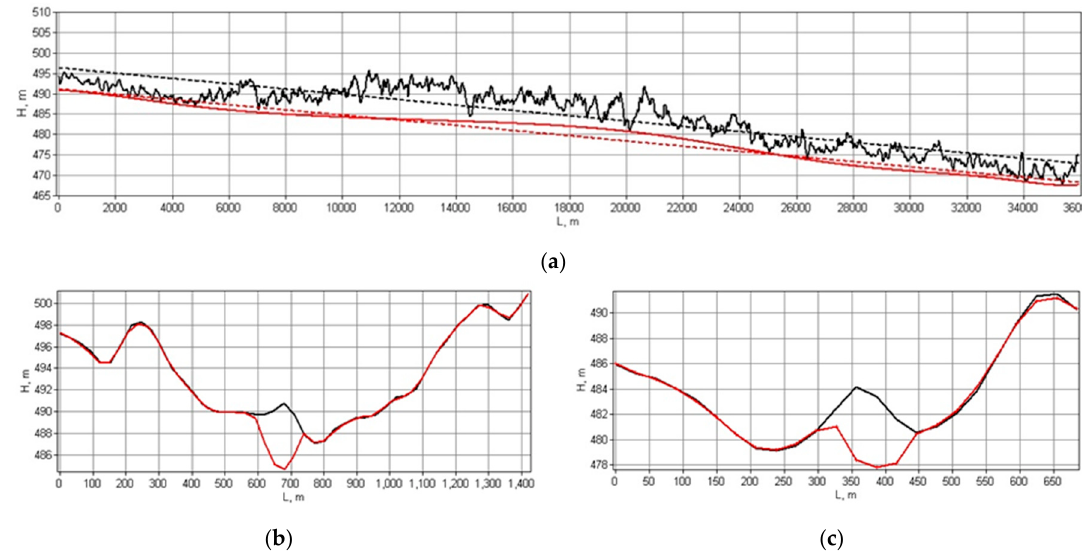
Figure 4. ( a ) Longitudinal profile along the corrected thalweg with the original digital elevation model (DEM SRTM) (black) and the hydrologically-conditioned digital elevation model (DEM SRTM TR ) (red), and average slope calculated by fitting a linear trend to the elevation profiles (dotted lines). Cross section profiles S4 ( b ) and S7 ( c ) with the original DEM SRTM (black) and the DEM SRTM TR (red).